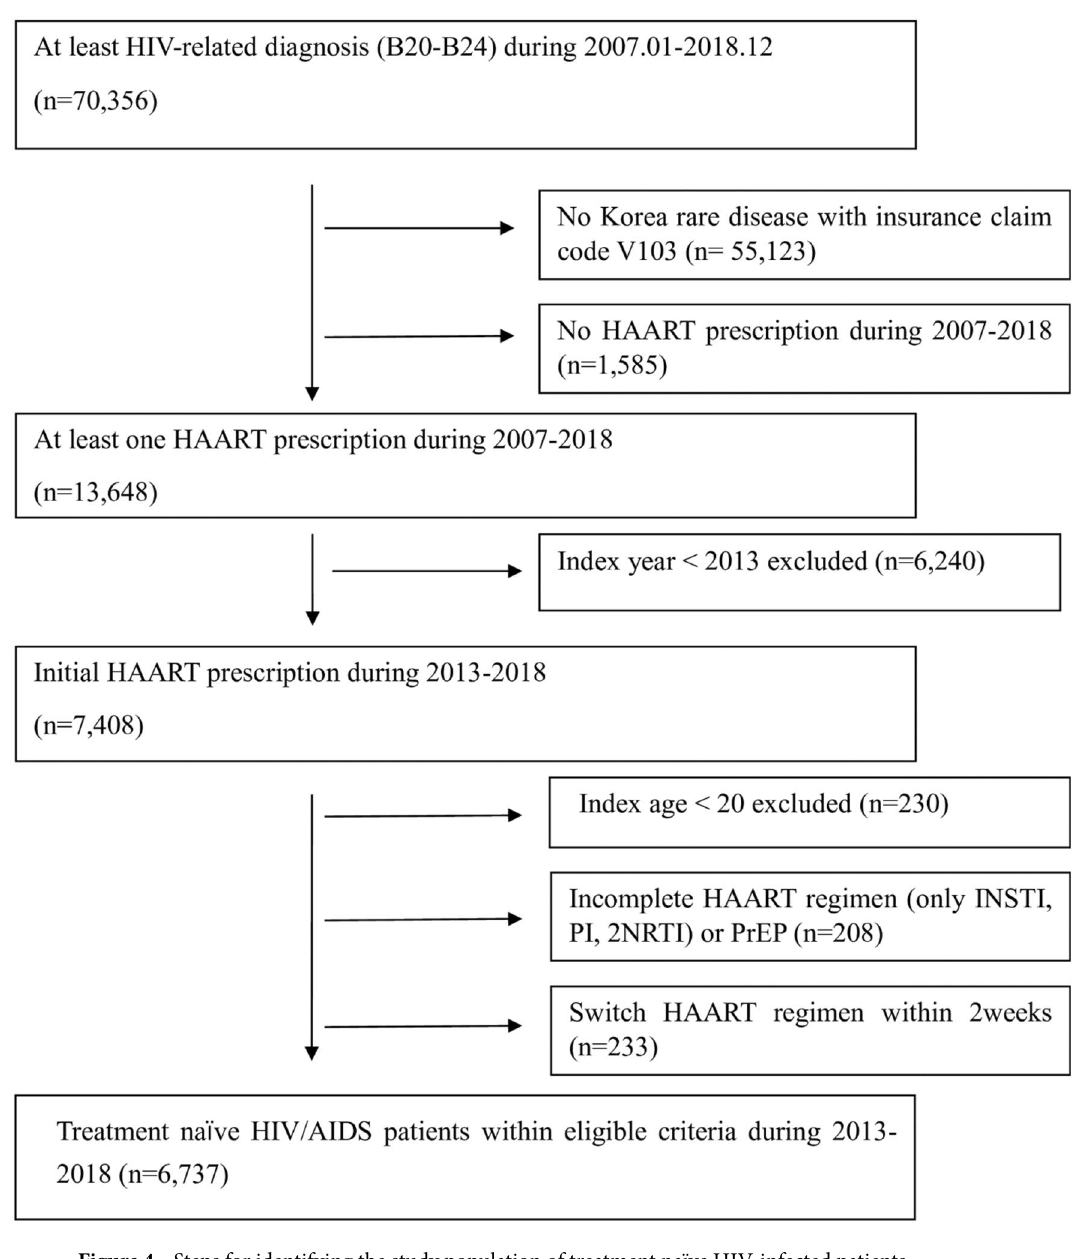
Figure 4. Steps for identifying the study population of treatment naïve HIV-infected